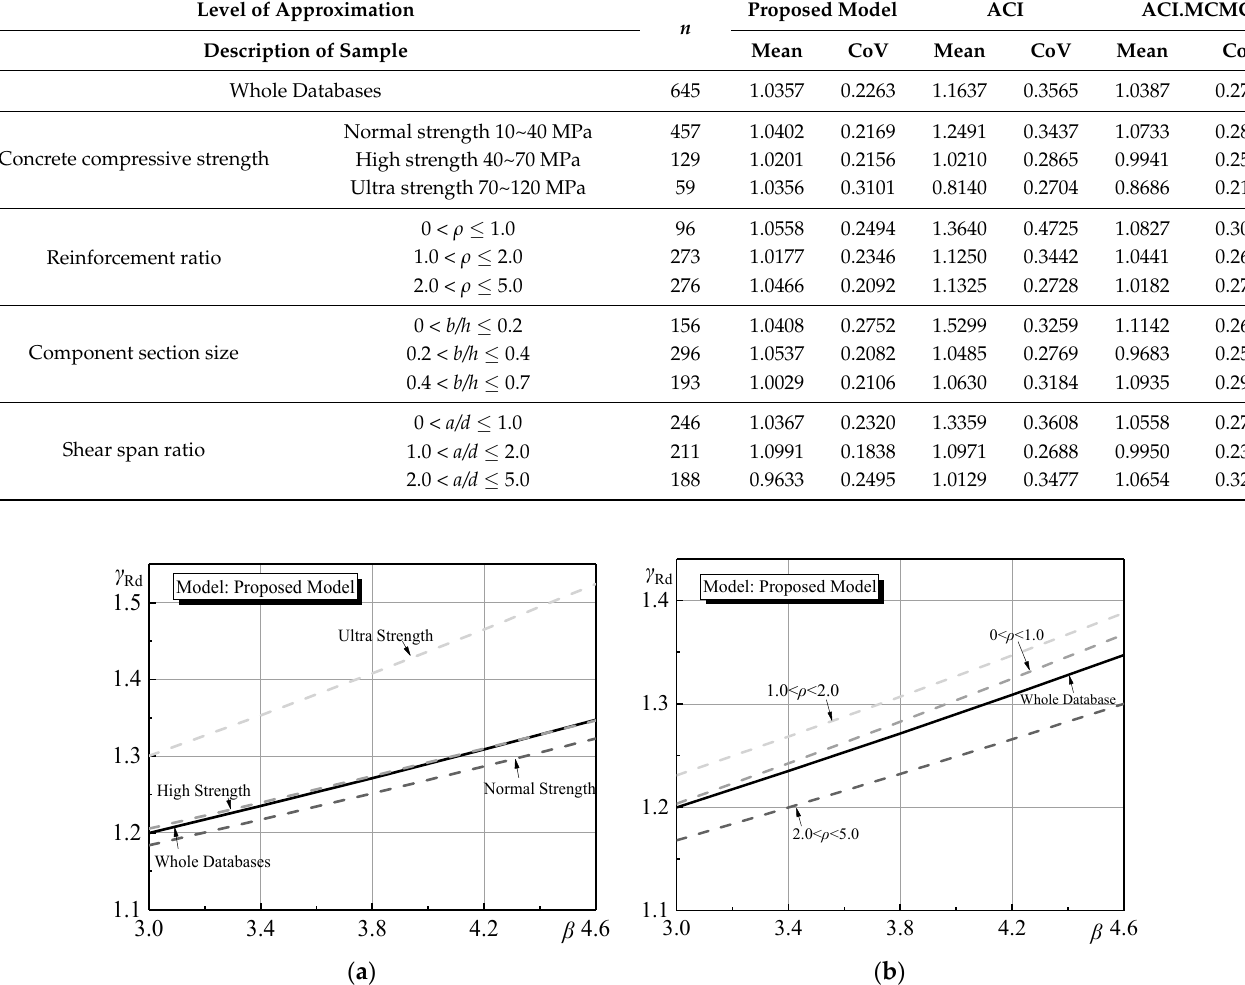
Figure 7. Variation of model uncertainty factor with target reliability. ( a ) f c ′ /MPa. ( b ) ρ /%.